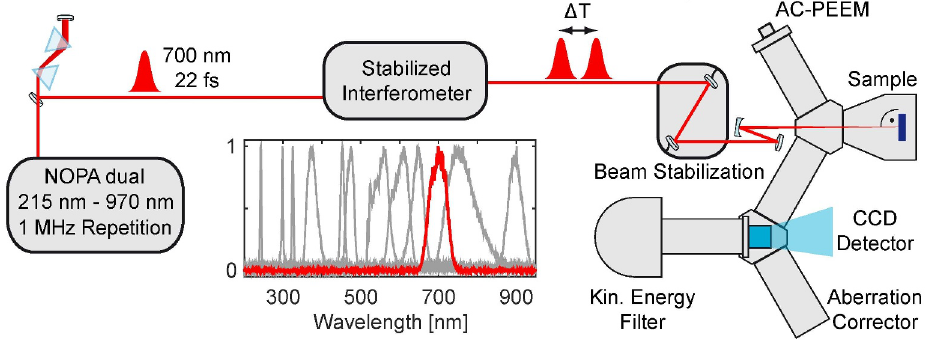
Fig. 1. Experimental setup: Phase-coherent pulse pairs are generated from a two-branch noncollinear optical parametric amplifier (NOPA) and an actively stabilized Mach-Zehnder-type interferometer. Representative NOPA spectra (gray) are shown as well as the 700 nm spectrum used in the experiment (red). The spatial distribution of emitted electrons is detected with aberration-corrected photoemission electron microscopy following active beam